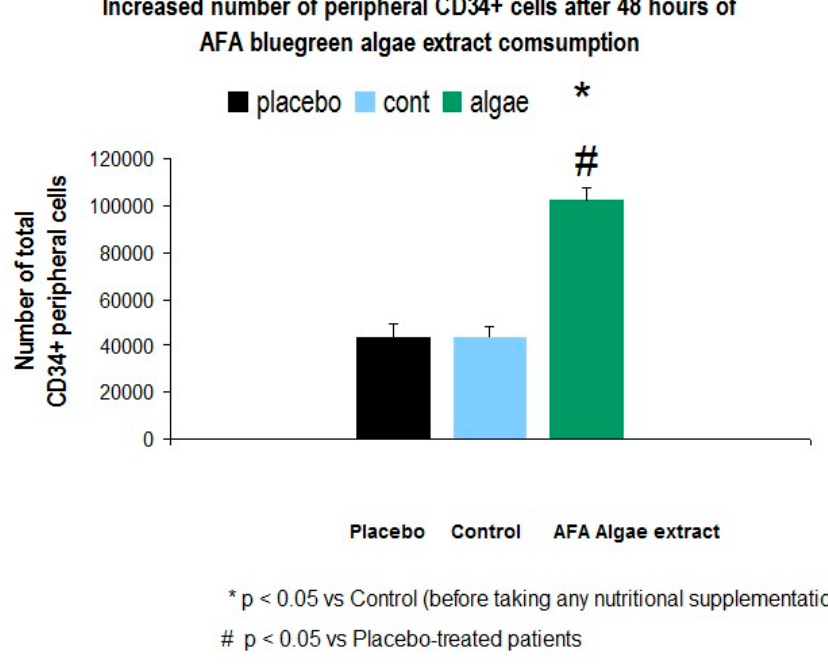
Figure 3. Short-term AFA supplementation over 48 h increases the total number of CD34+ peripheral cells in healthy subjects.